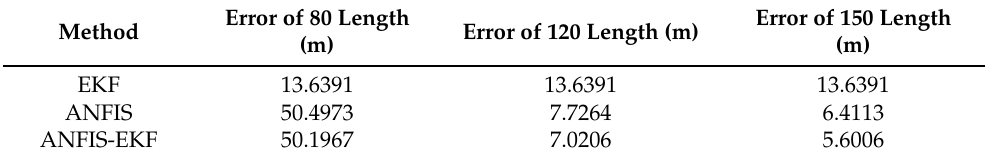
Figure 12. The experimental results of different training lengths. ( a ) Estimated trajectory of 80 train- ing length. ( b ) Positioning error of 80 training length. ( c ) Estimated trajectory of 120 training length. ( d ) Positioning error of 120 training length. ( e ) Estimated trajectory of 150 training length. ( f ) Positioning error of 150 training length. Table 5. The mean positioning error of different training